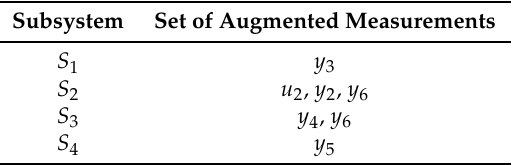
Table 1. Set of augmented measurements for each subsystem